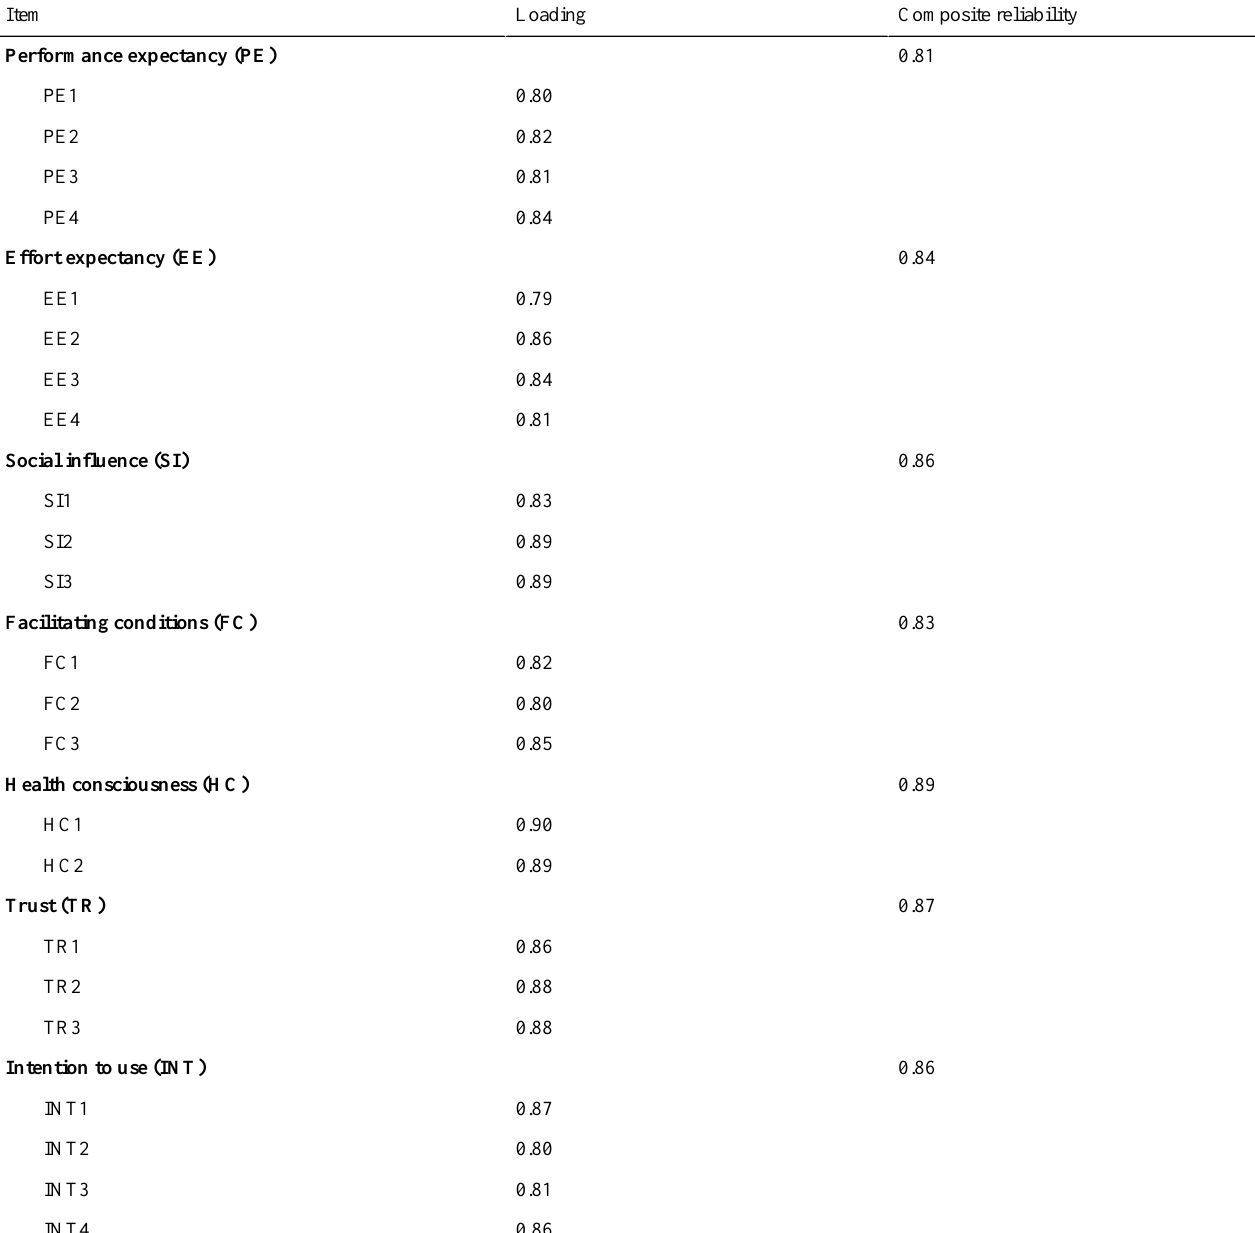
Table 1. Loading and composite reliability values for the items.